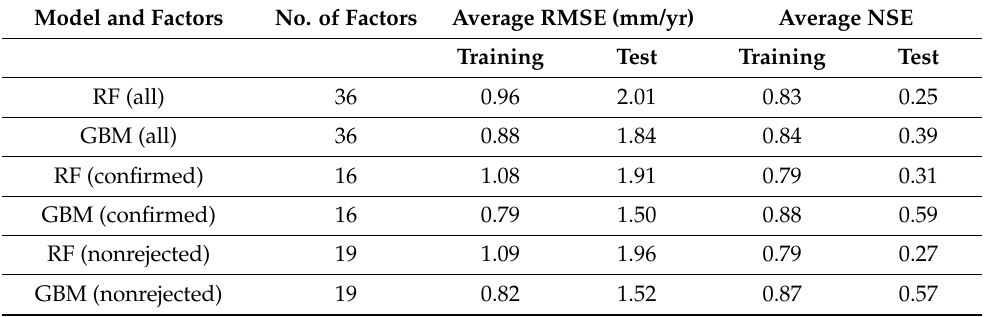
Table 3. Performance comparison of machine learning models using threefold cross-validation. Model and Factors